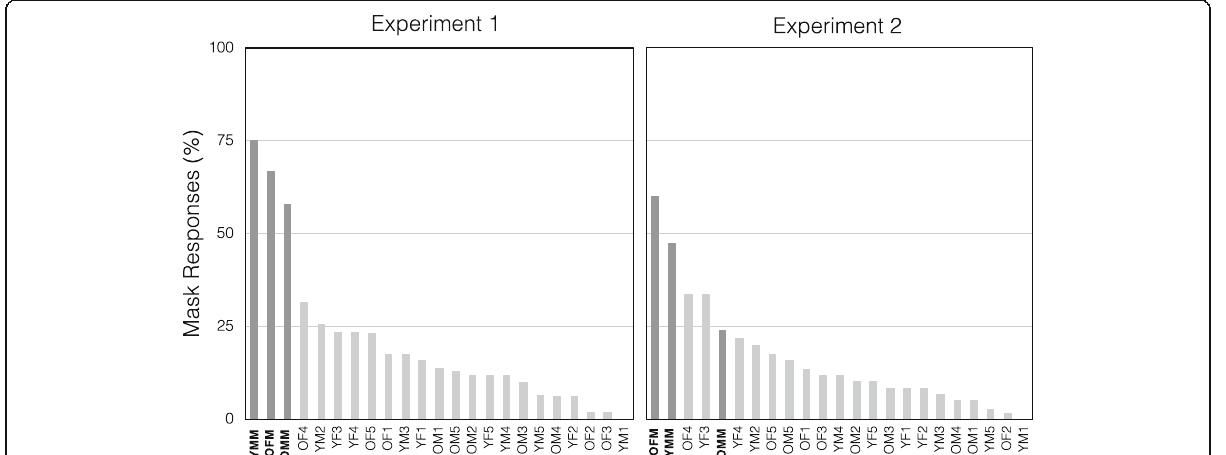
Fig. 3 Responses to the array challenge in Experiment 1 (left) and Experiment 2 (right). Bars show, for each image in the array, the percentage of participants who reported it as a mask, and are ordered by frequency. Dark bars represent mask images ( YMM young male mask, OFM old female mask, OMM old male mask). Light bars represent real face images ( YM young male, OM old male, YF young female, OF old